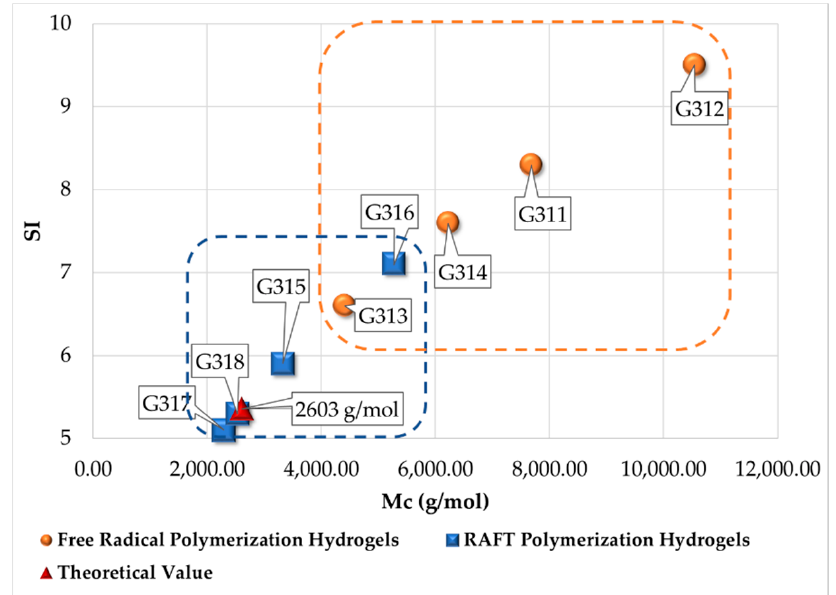
Figure 4. Correlation between experimental results of swelling index (SI) and calculated average molecular weight between crosslinks, using Equation (1). Processes 2017 , 5 , 26 10 of 23